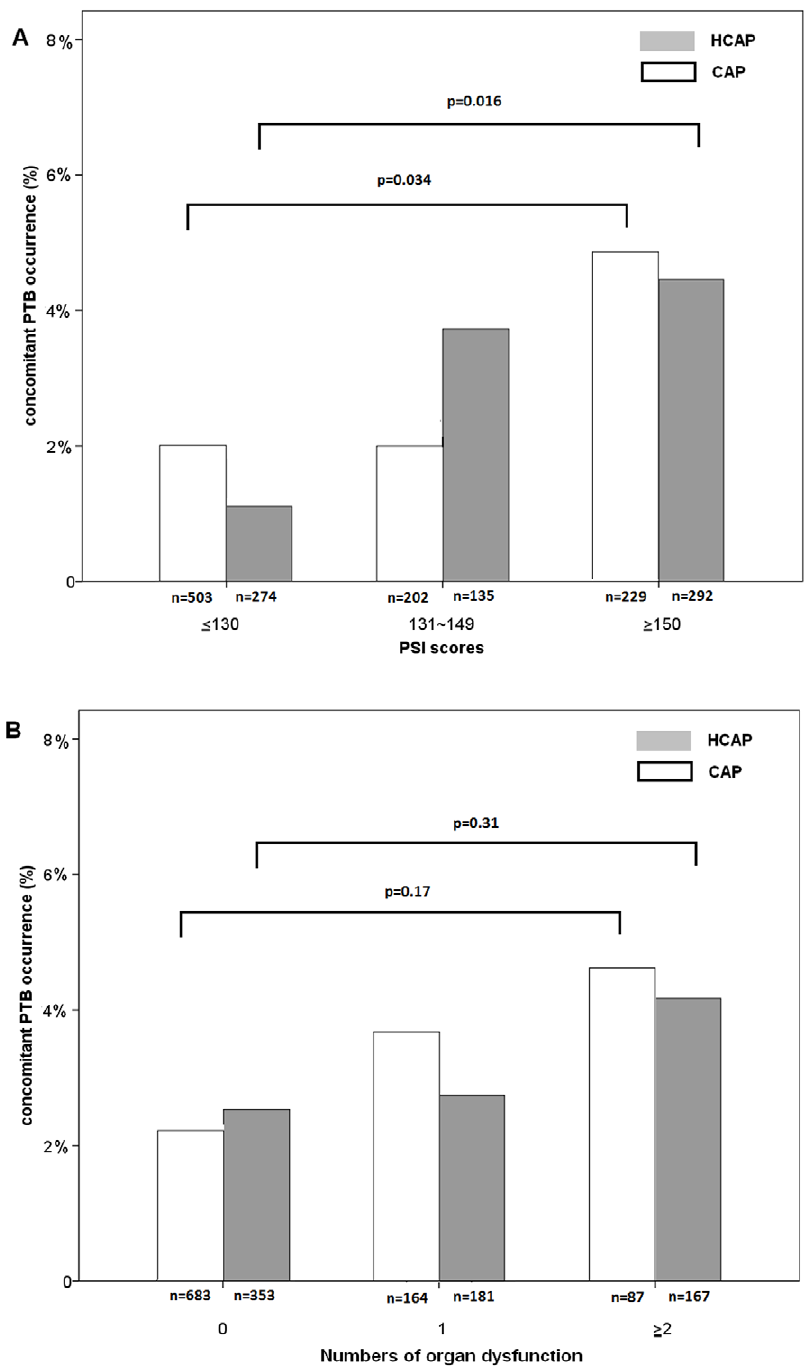
Figure 1. Occurrence of concomitant PTB among hospitalized HCAP and CAP patients with various severity. Patients are divided according to (A) PSI scores and (B) number of organ dysfunctions. HCAP, healthcare-associated pneumonia; CAP, community acquired pneumonia; PSI, pneumonia severity index; PTB, pulmonary tuberculosis. doi:10.1371/journal.pone.0036832.g001 PLoS ONE |